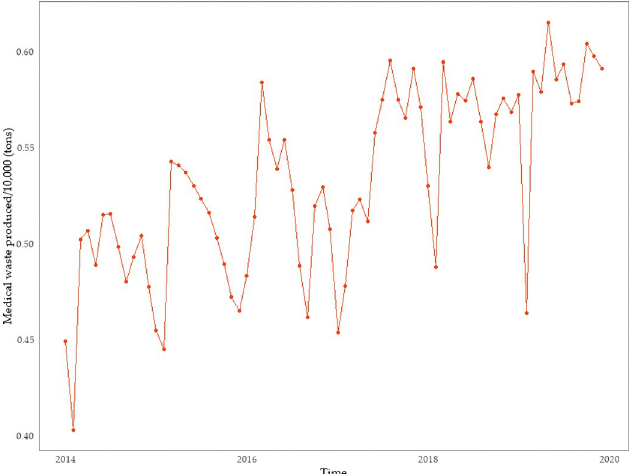
Fig 4. Plot showing the monthly production of medical waste in the Hubei Province,